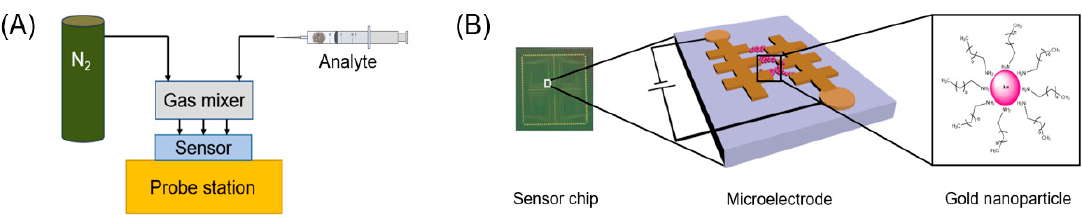
Figure 1. ( A ) Sensing experimental setup with the electronic nose sensor chip; ( B )